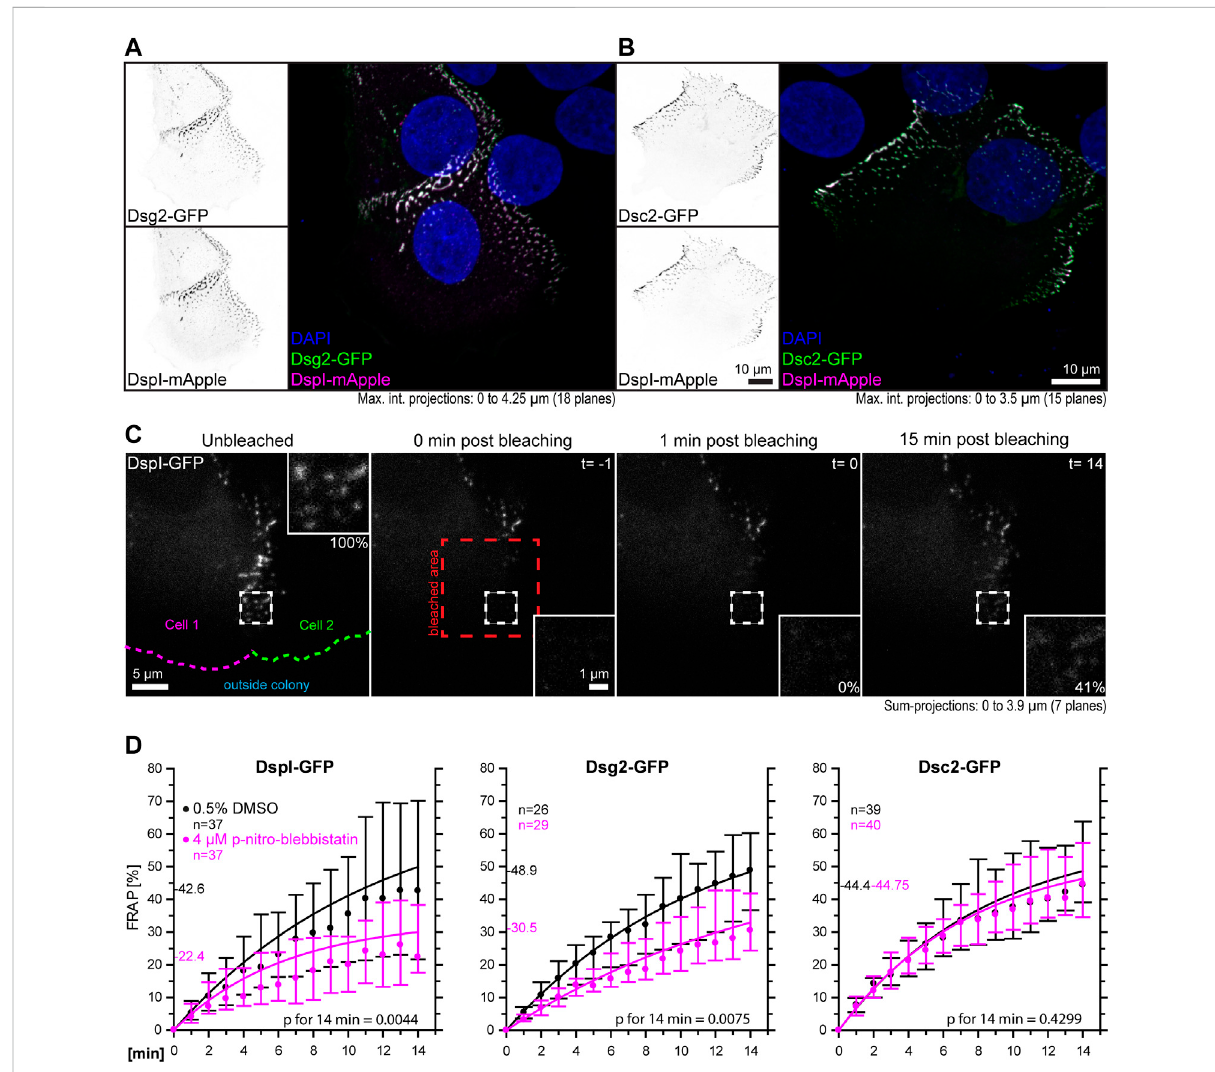
FIGURE 3 MyosinIIinhibitiondecreasesthedesmosomalturnoverofDspIandDsg2butnotofDsc2inHaCaTkeratinocytes.HaCaTcellsweretransfected with plasmids encoding fl uorescently tagged DspI (DspI-GFP or DspI-mApple), Dsg2 (Dsg2-GFP) or Dsc2 (Dsc2-GFP). (A,B) presents fl uorescence micrographs of cells doubly transfected to express either Dsg2-GFP or Dsc2-GFP together with DspI-mApple. Note that the fl uorescent molecules co-localizeinpunctatestructures,i.e.desmosomesthatarelocatedatbordersofpartiallyoverlappingcells. (C) showsaspectsofthework fl ow. Itpresents fl uorescenceimagesfromaFRAPexperimentinwhichcellsweretreatedwith0.5%DMSO.Thesum-projectionoverviewsshow fromleft to right the DspI-GFP signal in a cell just prior to bleaching, immediately, 1 and 15 min after bleaching with insets depicting the bleached region at high magni fi cation. Fluorescence recovery measurements were started 1 minute after bleaching at which time fl uorescence intensity was set as 0% and the corresponding time point was de fi ned as t = 0. In this way, diffusion-related rapid fl uorescence recovery was not taken into account for the quantitative measurements depicted in the graphs below. Aspects of this procedure are illustrated in Supplementary Movie S2 comparing solvent- treated to para-nitro-blebbistatin-treated cells. (D) The diagrams show time-dependent fl uorescence recovery curves of DspI-GFP, Dsg2-GFP, and Dsc2-GFP that were started 1 min after bleaching (= time point 0). The experiments were performed as illustrated in (C) . Dots represent medians, whiskers correspond to the 25 – 75th percentiles, and statistical analysis was performed with a Mann-Whitney test 14 min after the measurements were